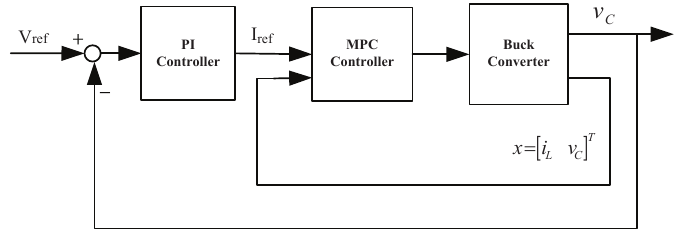
Figure 5. The block diagram of voltage